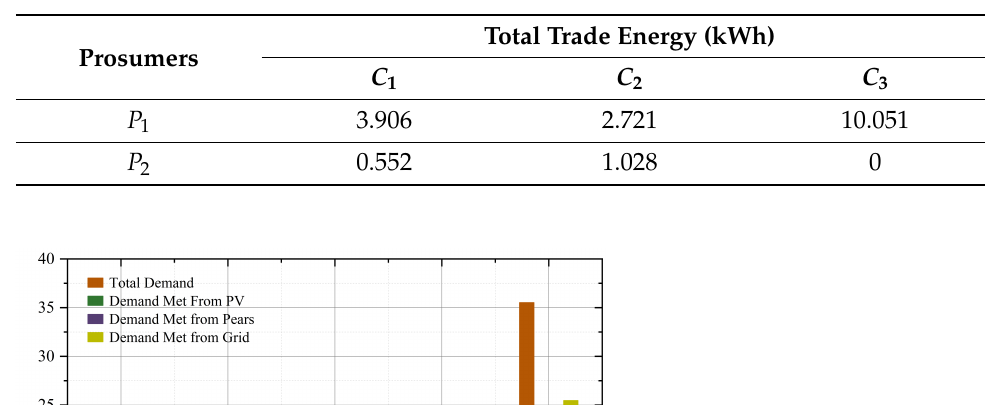
Table 6. Total energy trade between prosumer and consumers